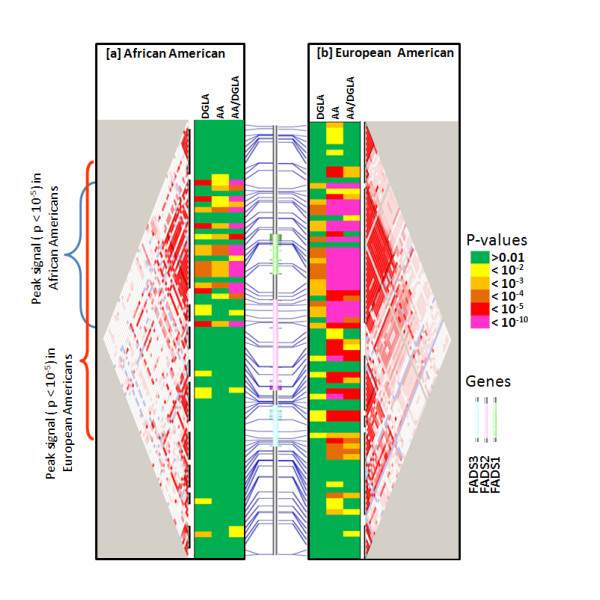
Peak Association by Race. Tests for association for AA, DGLA and FADS1 enzymatic activity (AA/DGLA) in the ascertained sample from GeneSTAR in African Americans and European Americans for 100 SNPs on chromosome 11q13. Strength of Association depicted as in the legend, LD patterns (low to strong ranging from white to red) along with LD blocks (black triangles), and physical location of SNPs (blue lines) relative to the three FADS genes (see insert).